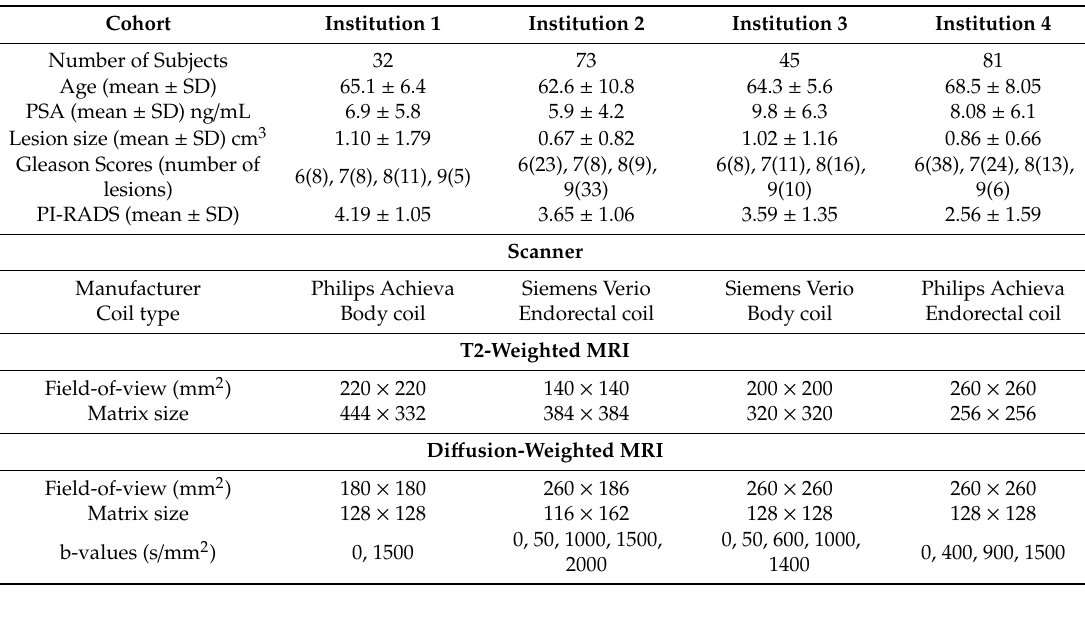
Table 3. Dataset description.